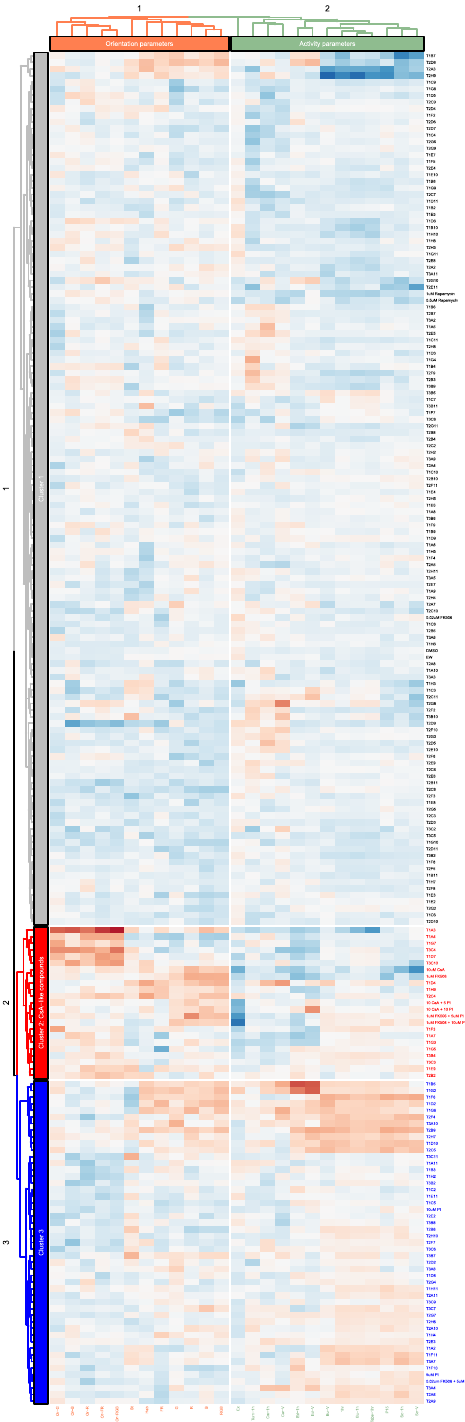
Figure 5. Hierarchical clustering: 25 behavioral parameters were used to produce a heatmap of various behavioral measures for each drug compound. The red-blue color spectrum represents values ranging from − 10 (red) to 5 (blue). Using the hierarchical clustering on the Euclidean distances of each compound, we identified 3 separate clusters depending on the behavioral profile of these drugs. Hierarchical clustering analysis uses the magnitude of effect to reveal clusters of compounds with similar effects on behavior. Cluster 2 (red) was identified and labeled as a CsA-type cluster as CsA and FK506 clustered with 17 novel seemingly unrelated compounds. The CsA-type cluster shows a typical heatmap pattern with lower values for orientation parameters and higher activity parameters. The CsA-type cluster also contained a tight cluster of rescue (CsA/FK506 + PI) experimental groups suggesting that supplementing ProINDY (PI) with CsA/FK506 is not sufficient to rescue behavioral effects produced by calcineurin inhibitors. Cluster 1 (grey) consisted of EW and DMSO controls along with a majority of (132) compounds from the drug library. This cluster did not show larger values for any of the orientation or activity parameters. Cluster 3 (blue) consisted of drugs ProINDY along with 48 other drug compounds. ProINDY activates NFAT via the inhibition of an inhibitor (DYRK1A) and induces behaviors that are nearly opposite to the CsA-induced behaviors. This cluster showed a behavioral profile with larger values orientation and lower activity values; a pattern that was the reverse of CsA-type